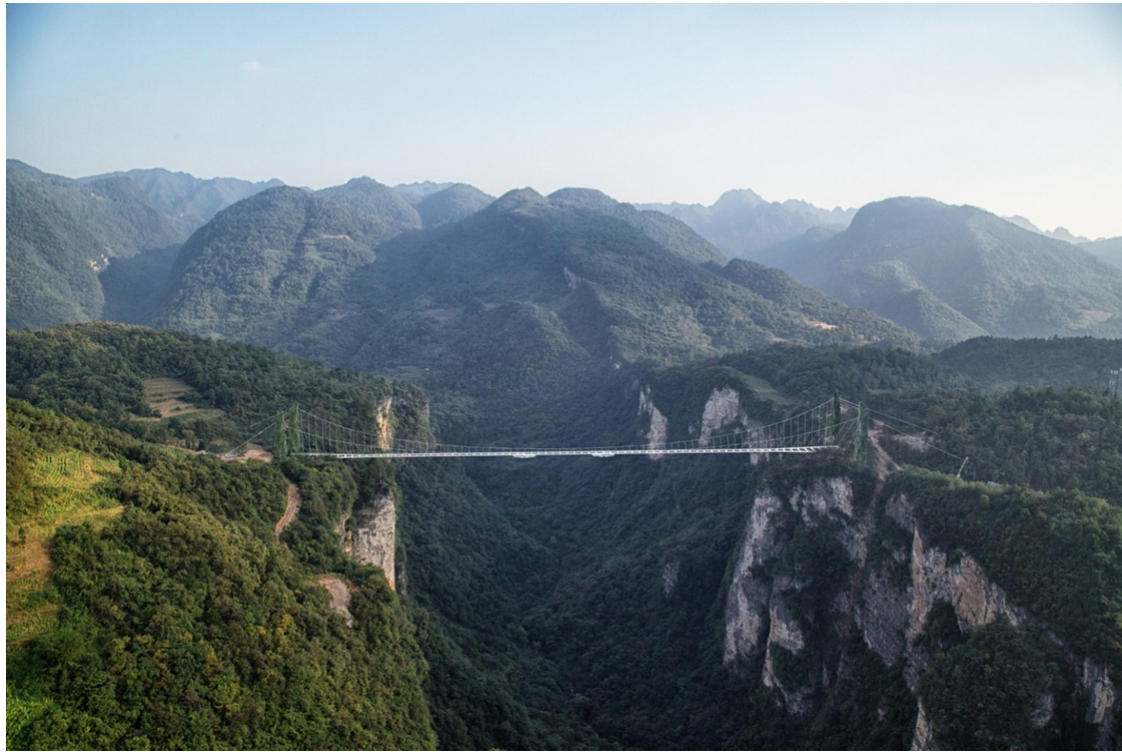
Fig. 4 Zhangjiajie bridge, aerial view